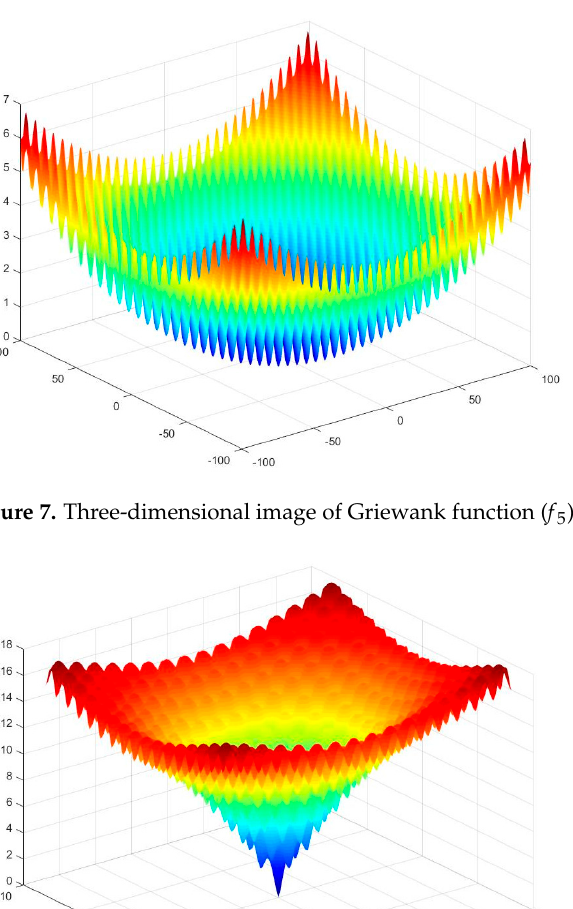
Figure 6. Three-dimensional image of Schwefel function ( f 4 ).